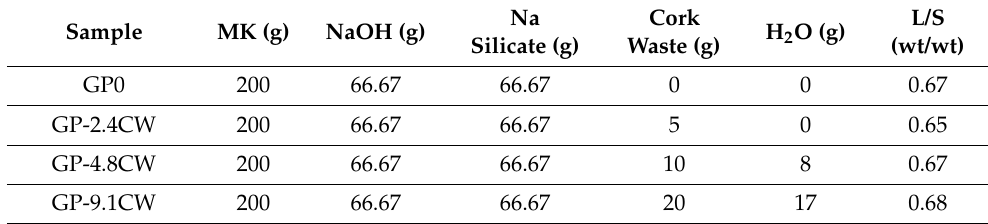
Table 1. Geopolymer formulations (L/S = liquid to solid ratio, see text for description).